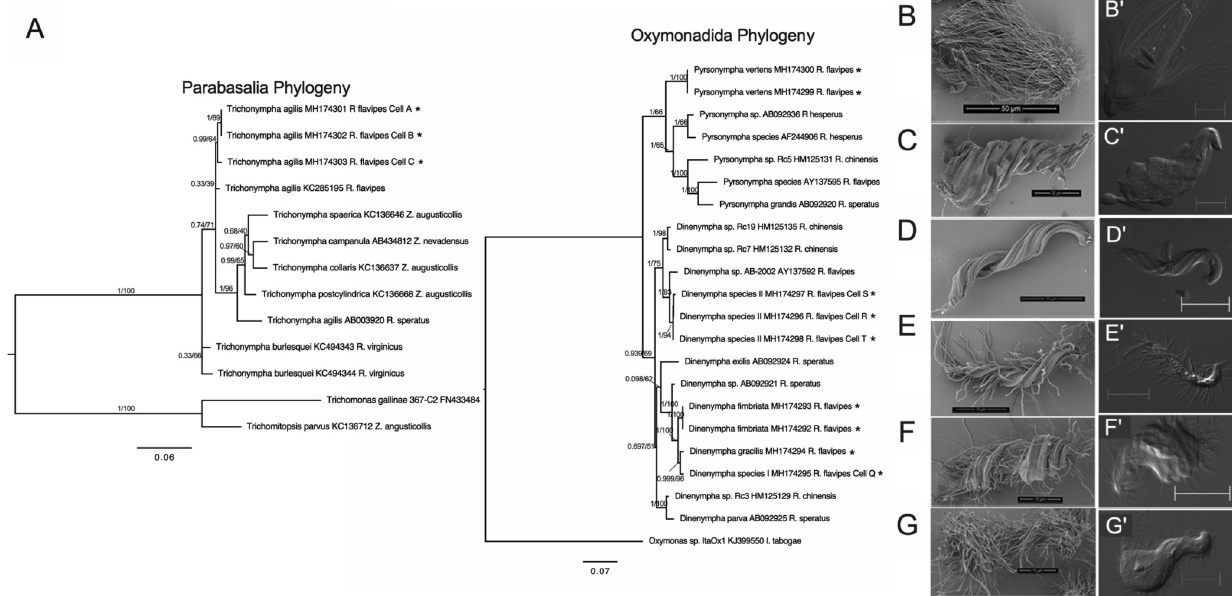
Fig 1. Phylogenetic and morphological diversity of hindgut protist species from R . flavipes . (A) Maximum likelihood (ML) phylogenetic trees of 18S rRNA genes from single protists cells. Parabasalia ML tree (left) was generated using the program IQ-Tree with substitution model GTR+I+G4 while the Oxymonadida ML tree (right) was generated using the substitution model TN+I+G4. Four 18S rRNA genes from single protist clustered to known references sequences ( D . fimbriata , D . gracilis , P . vertens , and T . agilis ). Other previously undescribed protists, D . species I and D . species II, clustered within the genus Dinenympha . Taxa marked by ( � ) represents sequences obtained by this study. Sequences from cells which are designated by a letter represent individuals in which the 18S rRNA gene was co-amplified with the bacterial V4 16S rRNA gene. Tip labels include the protist name, accession number, and host termite species. Support values represent the Bayesian posterior probability and Bootstrap support values respectively. Scanning electron micrographs, and DIC images of representative individuals of each protist species (B, B’) T . agilis , (C, C’) P . vertens , (D, D’) D . gracilis , (E, E’) D . fimbriata , (F, F’) D . species I and (G, G’) D . species II. Electron micrograph scale bars represent 50 μ m (B), 30 μ m (C), and 10 μ m (D–G), all DIC scale bars are 20 μ